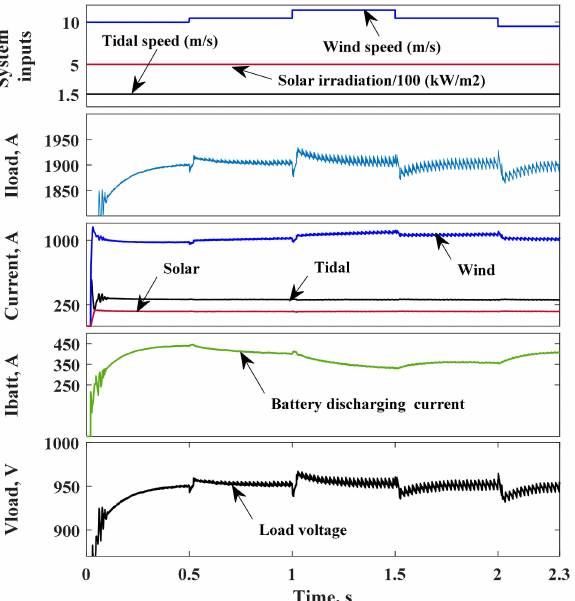
Figure 17. Case-b: performance of a single floating energy unit at energy deficit condition when RES supply lower energy than load